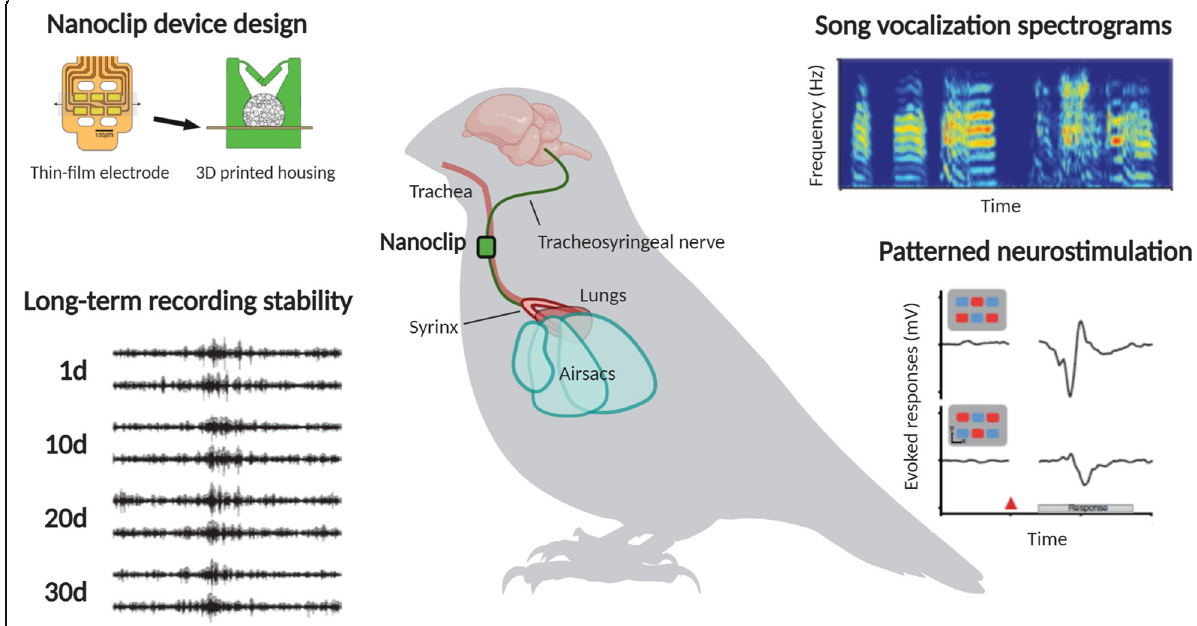
Fig. 1 Optimized bioelectronic approach for peripheral nerve interfacing. Long-term recording and stimulation of the tracheosyringeal nerve in the zebra finch with an implanted nanoclip device. The study design exemplifies an optimized approach for performing recordings and tunable stimulation on a small peripheral nerve. The nanoclip device consists of a thin-film microfabricated electrode coupled to a custom 3D-printed housing with hinged trap doors to hold the nerve in place. High signal-to-noise ratio electrophysiological recordings were stable for over 4 weeks with the nanoclip. To measure functional differences in the output of the circuit, the acoustic structure of song vocalizations was quantified using high-resolution spectrograms. Patterned neurostimulation with current steering evoked distinct compound responses from the nerve reflecting differential fiber activation and also elicited distinct song vocalizations. Figure created using BioRender.com with portions adapted from (Otchy et al.